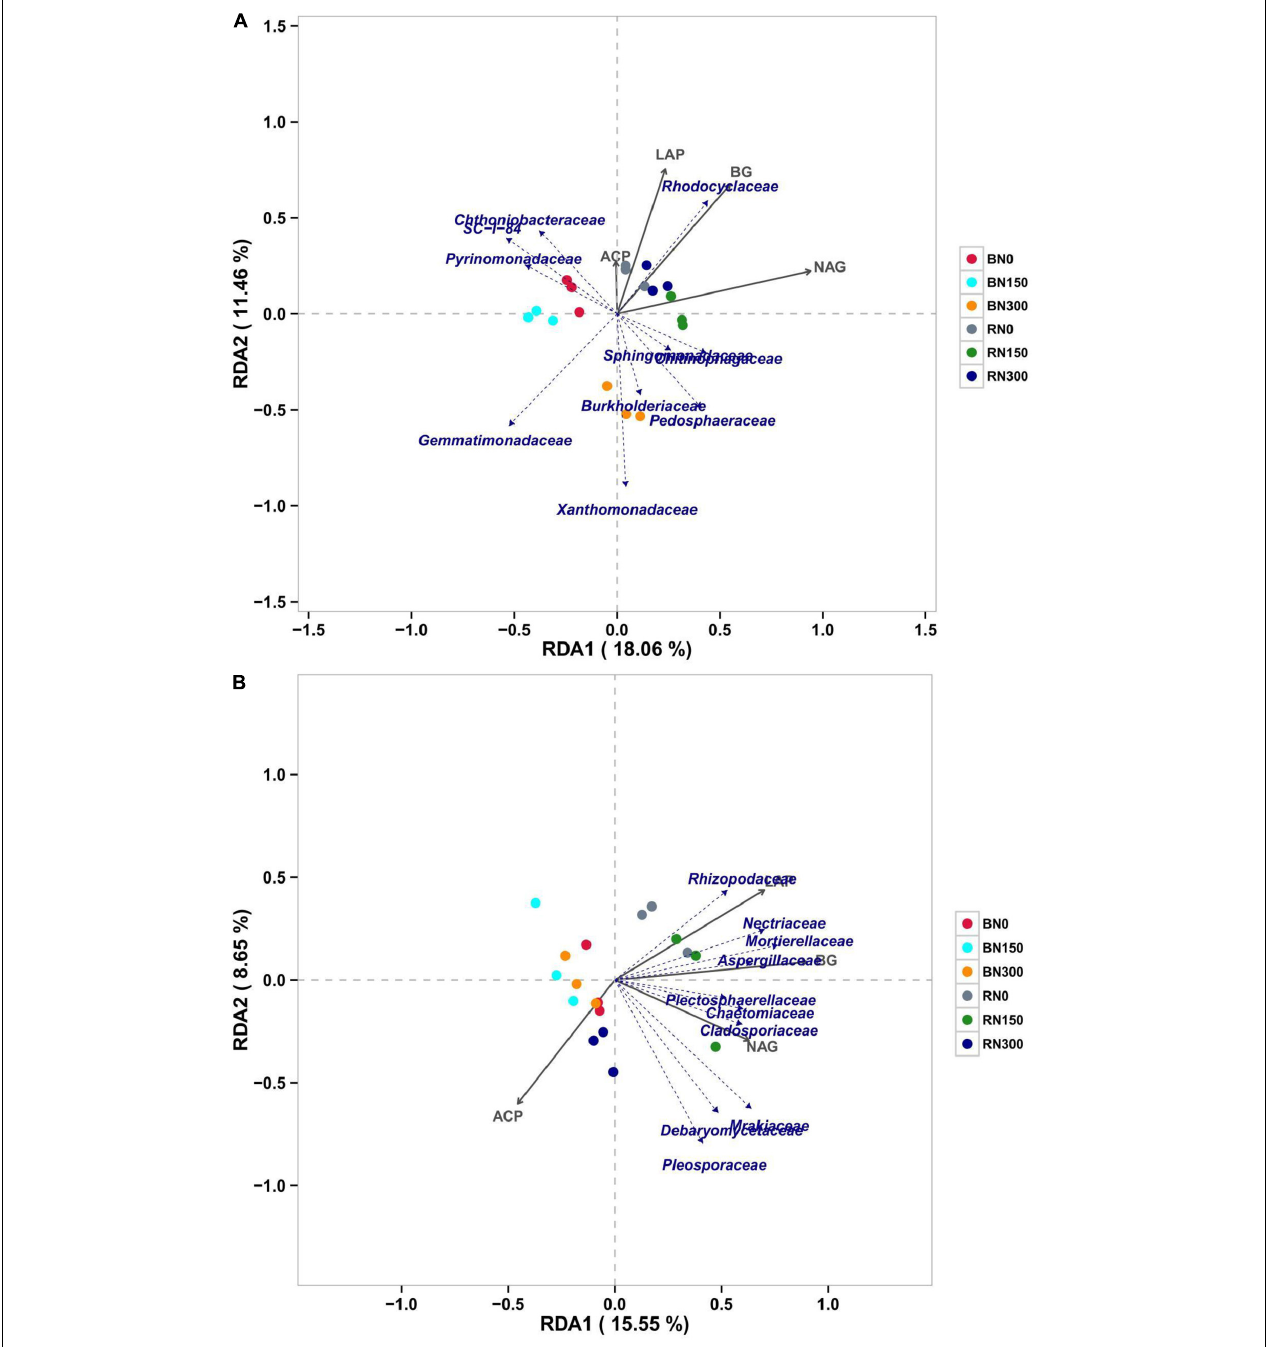
FIGURE 5 | Correlation between bacterial (A) and fungal (B) communities and soil enzyme activities explored using RDA (redundancy